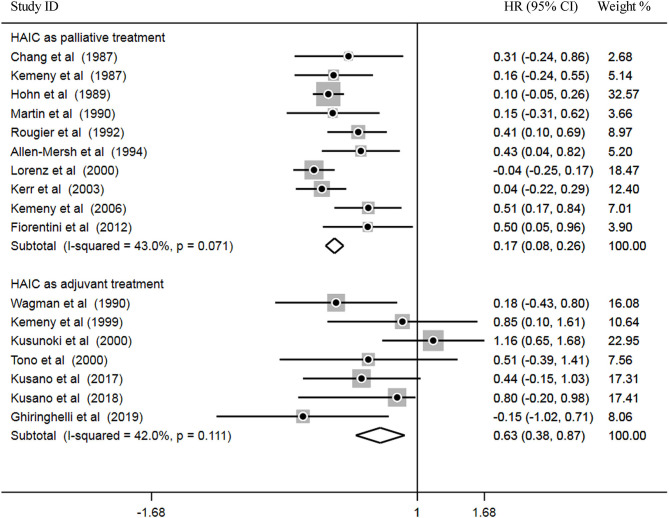
Forest plot of hazard ratios (HR) for OS.